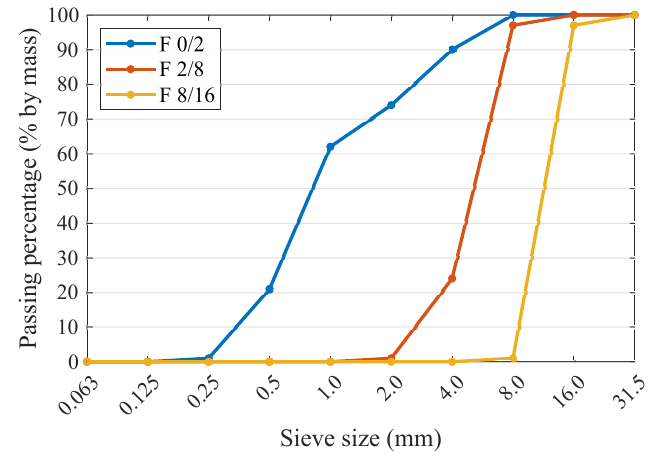
Figure 2. Particle size distribution of aggregates used in the production of HPC. Table 2. Physical properties of aggregates.